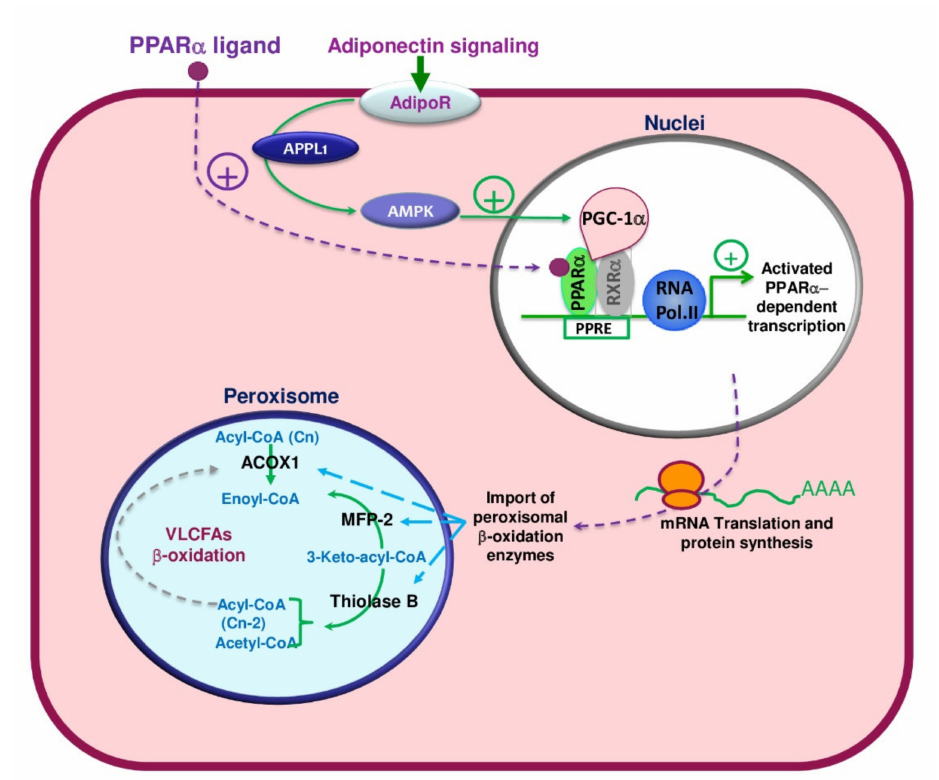
Figure 8. PPAR α -dependent regulation of peroxisomal fatty acid b-oxidation in rat liver through adiponectin signaling. Adiponectin: a hormone produced by adipose tissue that plays a role in lipid and glucose metabolism regulation; AdipoR, adiponectin receptor; APPL1, an adaptor protein containing a PH domain, PTB domain, and leucine zipper motif 1, plays a central role as the main contributing factor in the adiponectin and insulin signaling; AMPK, AMP kinase; PGC1- α , PPAR γ coactivator1 α ; PPRE, peroxisome proliferator-activated receptor; RNA Pol II, RNA-polymerase II; ACOX1, acyl-CoA oxidase 1; MFP2, multifunctional protein 2; thiolase B, 3-ketoacyl-CoA thiolase B; VLCFA, very-long-chain fatty